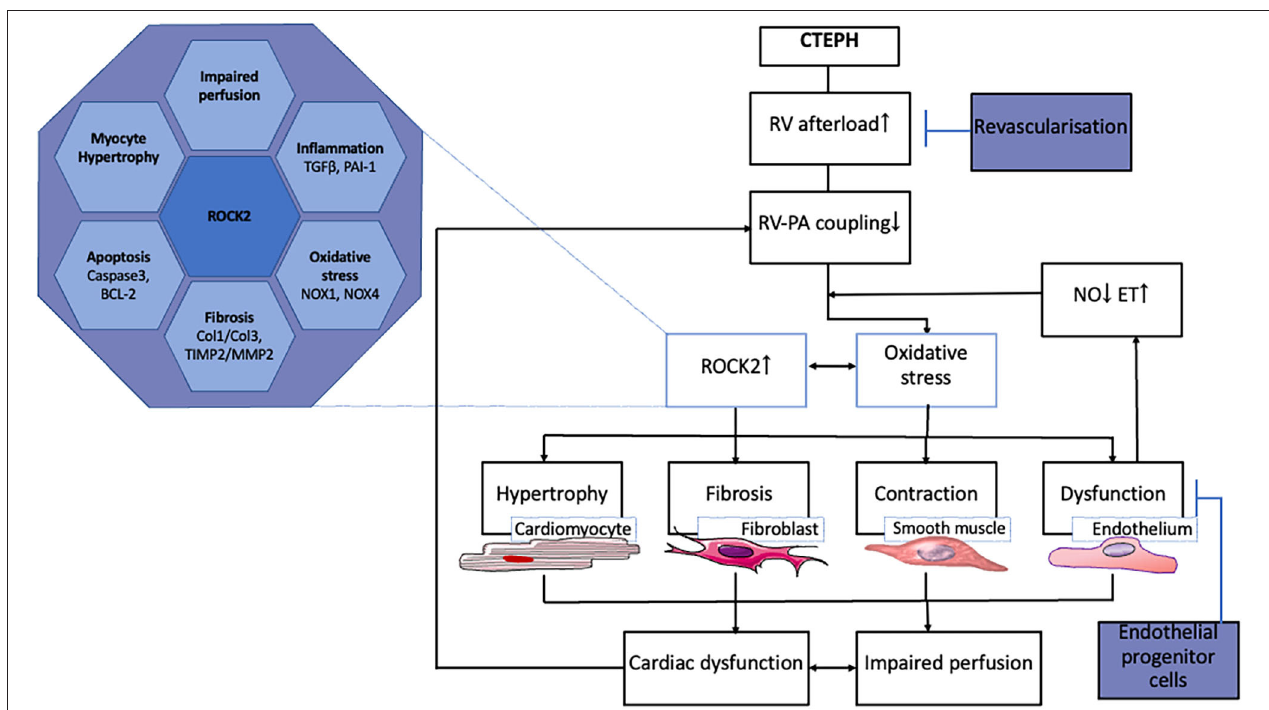
FIGURE 2 | Processes involved in RV remodeling in CTEPH and therapeutic interventions tested in animal